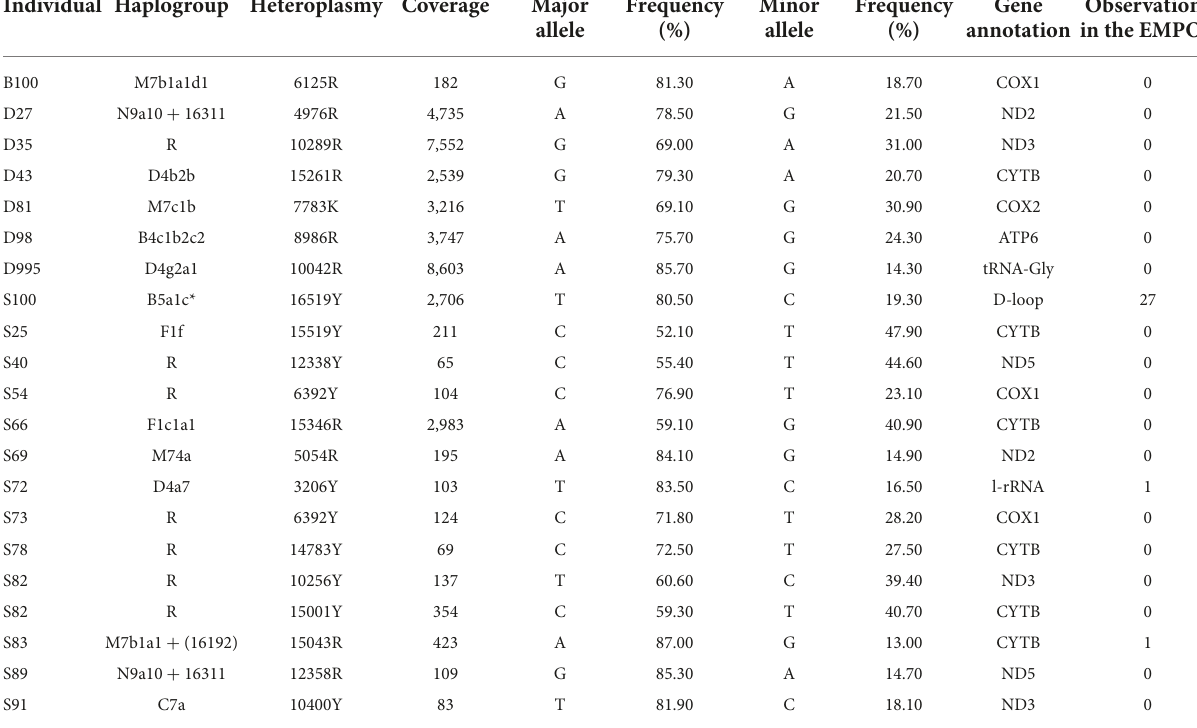
TABLE 2 Point heteroplasmies detected in 287 Guizhou Tai-Kadai-speaking individuals. Individual Haplogroup Heteroplasmy